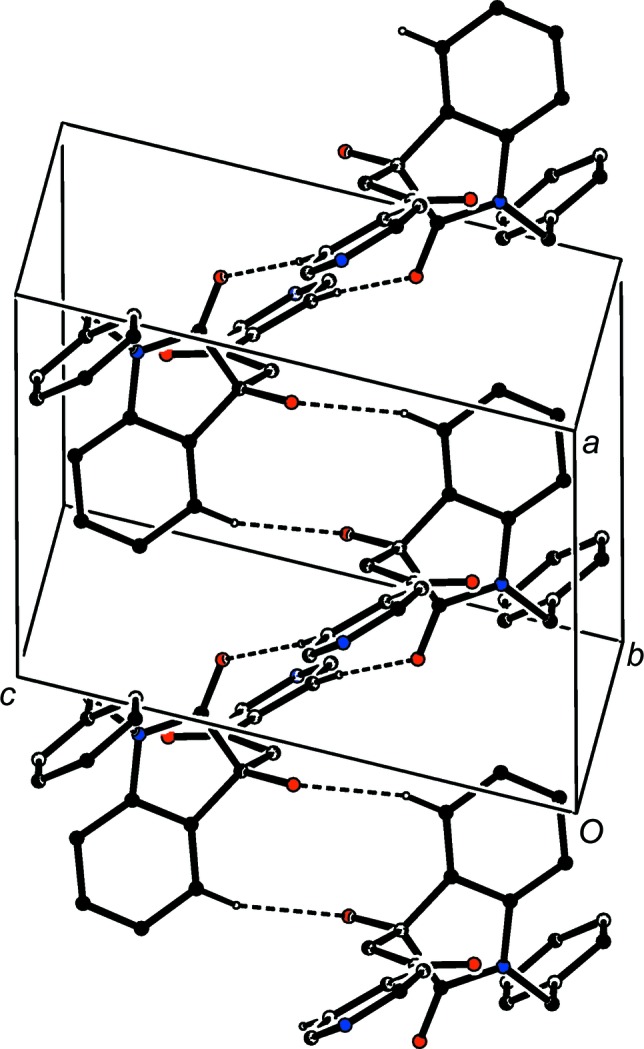
Part of the crystal structure of com­pound (Ie), showing the formation of a chain of rings running parallel to the [100] direction and built from two types of C—H⋯O hydrogen bonds. Hydrogen bonds are drawn as dashed lines and, for the sake of clarity, H atoms not involved in the motifs shown have been omitted.